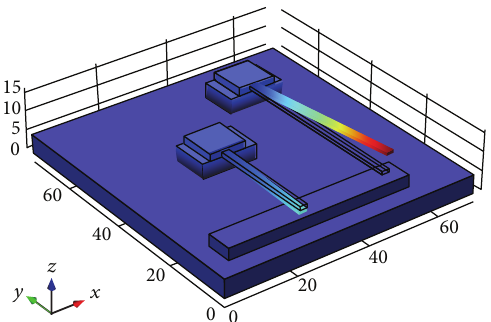
Figure 6: Schematic of a complete simulated device.